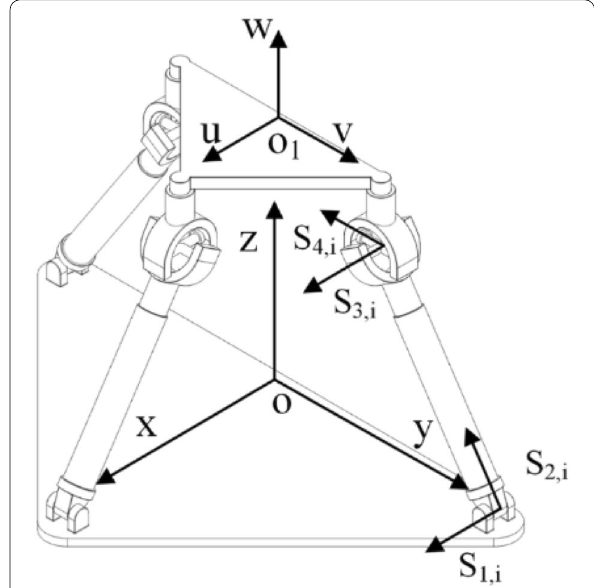
Figure 1 2R1T PM with rotational bifurcation